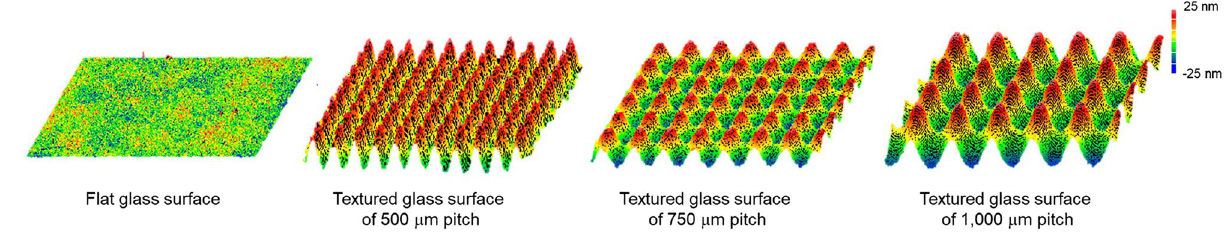
Figure 1. Images of glass surfaces considered as writing-surface specimens (flat glass, pitch of 500 μm, 750 μm, and 1000 μm).